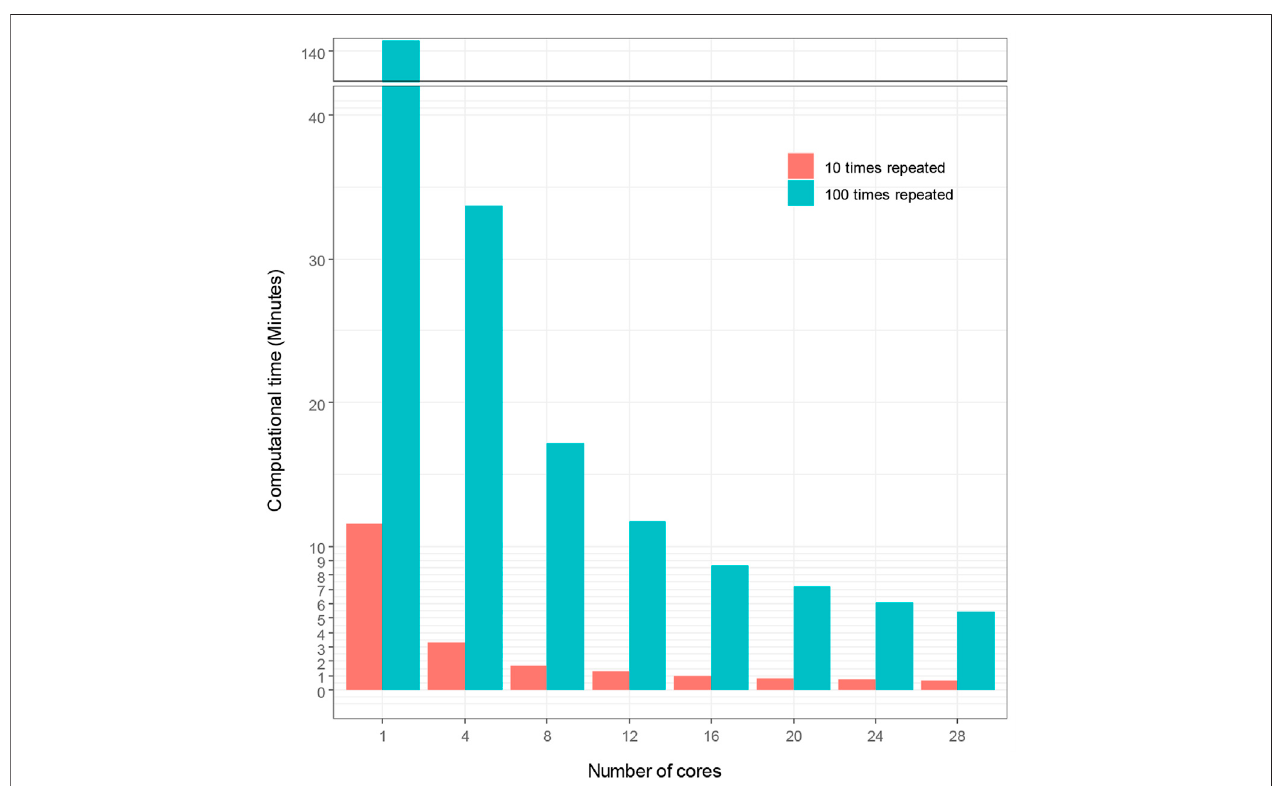
FIGURE 2 | Computational time vs. number of cores with SVM